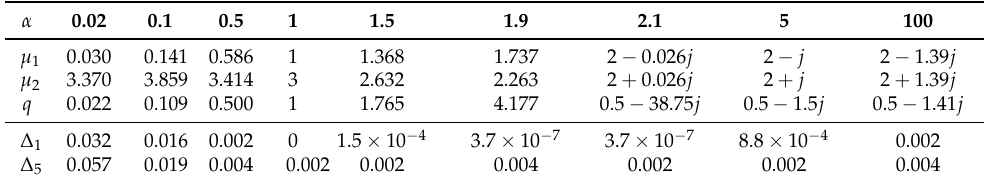
Table 1. Values of parameters µ 1 , µ 2 , and q of the hyperexponential approximation obtained for gamma distribution function for various values of its shape parameter α , and corresponding Kol- mogorov distances ∆ for the main result.